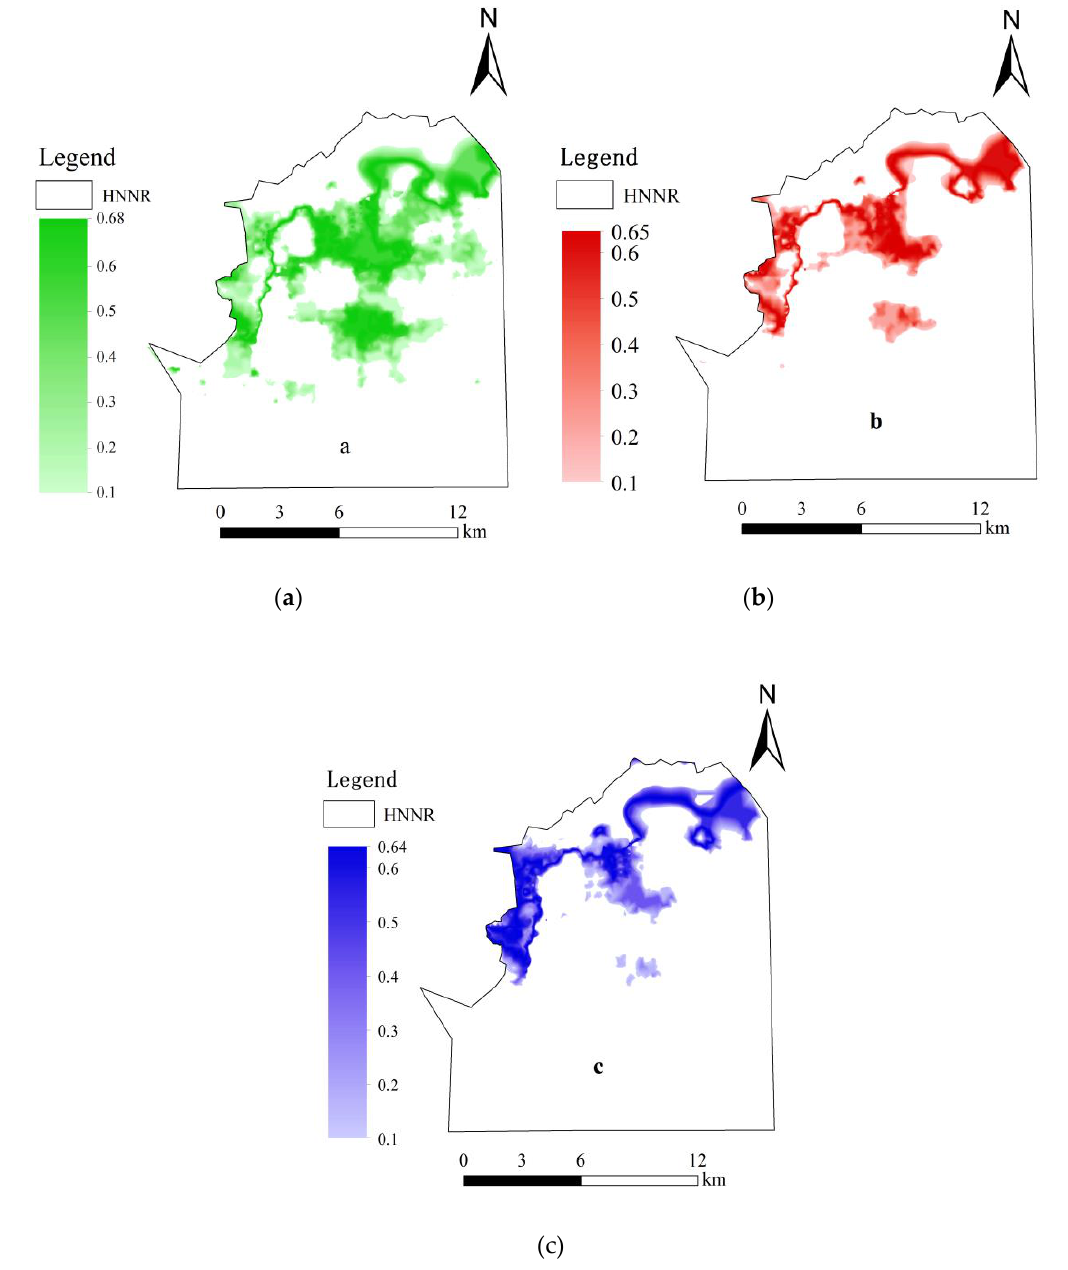
Figure 6. Spatial distribution probability maps of wetland vegetation ( a ): Calamagrostis angustifolia ; ( b ): Carex lasiocarpa ; ( c ): Carex pseudocuraica .